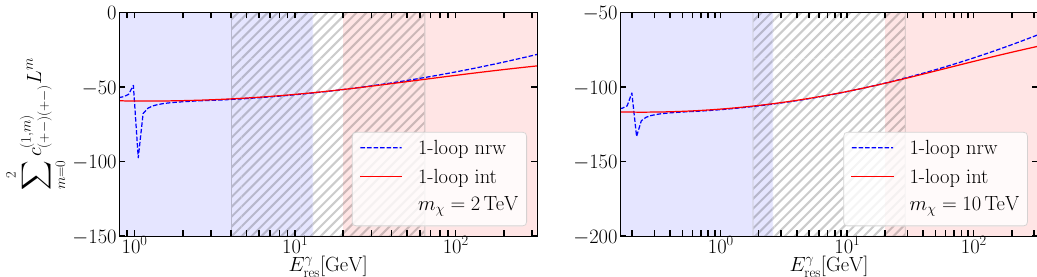
Figure 7 . One-loop coefficient of the series (5.3) (including all logarithms) for the ‘nrw’ (solid) and ‘int’ (dashed) factorization formulas. Left: m χ =2 TeV. Right: m χ =10